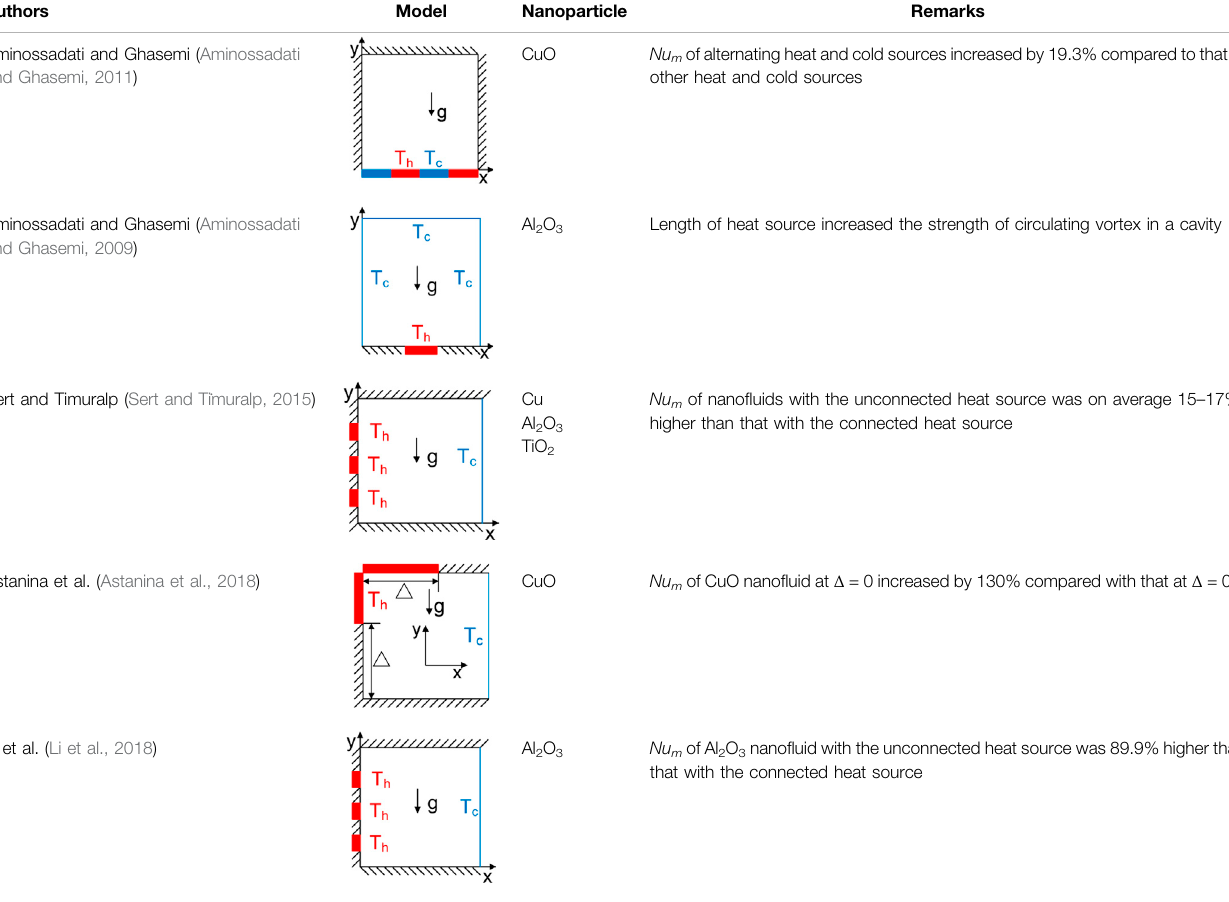
TABLE 4 | Information of water-based nano fl uids inside enclosures with arrangements of heating